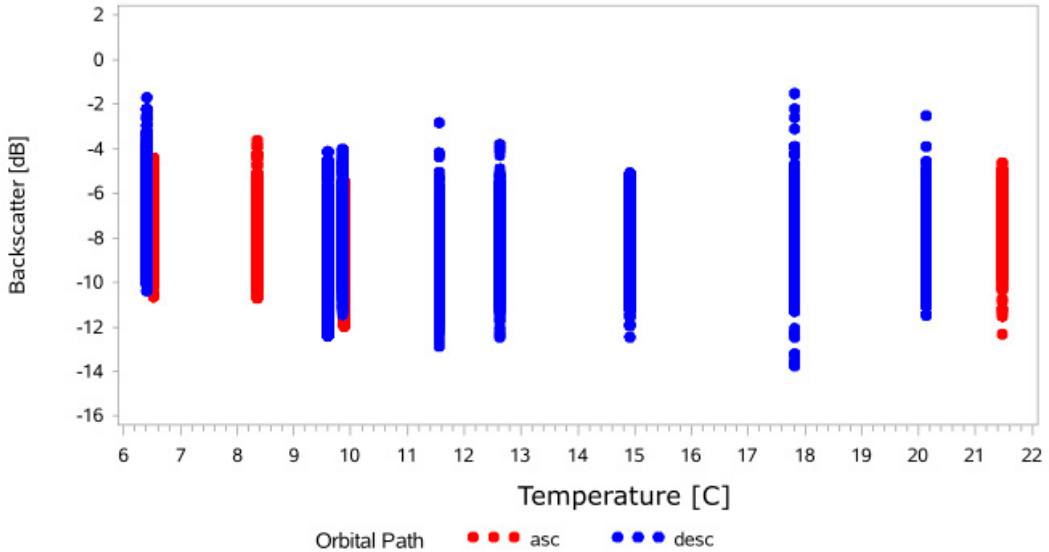
Figure 7. Backscatter variation with temperature. A slight increase in backscatter is observed at lower temperatures (6–10 °C) when compared with higher temperatures.